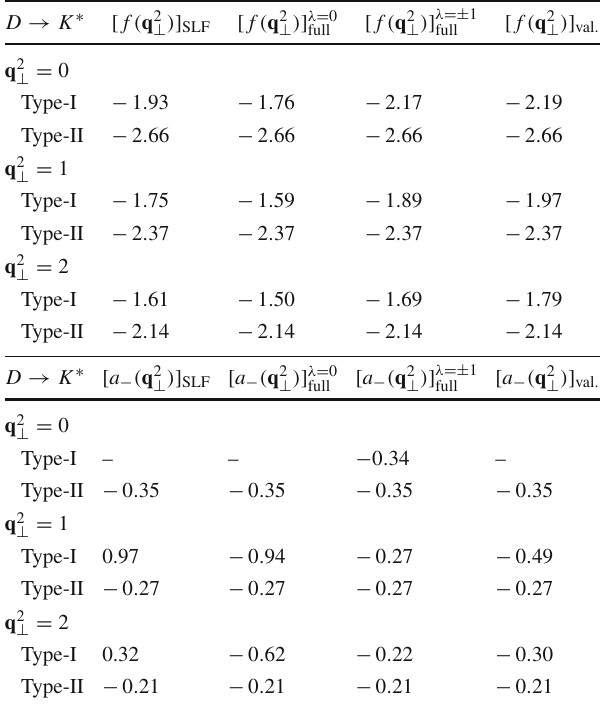
Table 3 Numerical results of the zero-mode dependent form factors f ( q 2 ⊥ ) and a − ( q 2 ⊥ ) at q 2 ⊥ = ( 0 , 1 , 2 ) GeV 2 for D → K ∗ transition